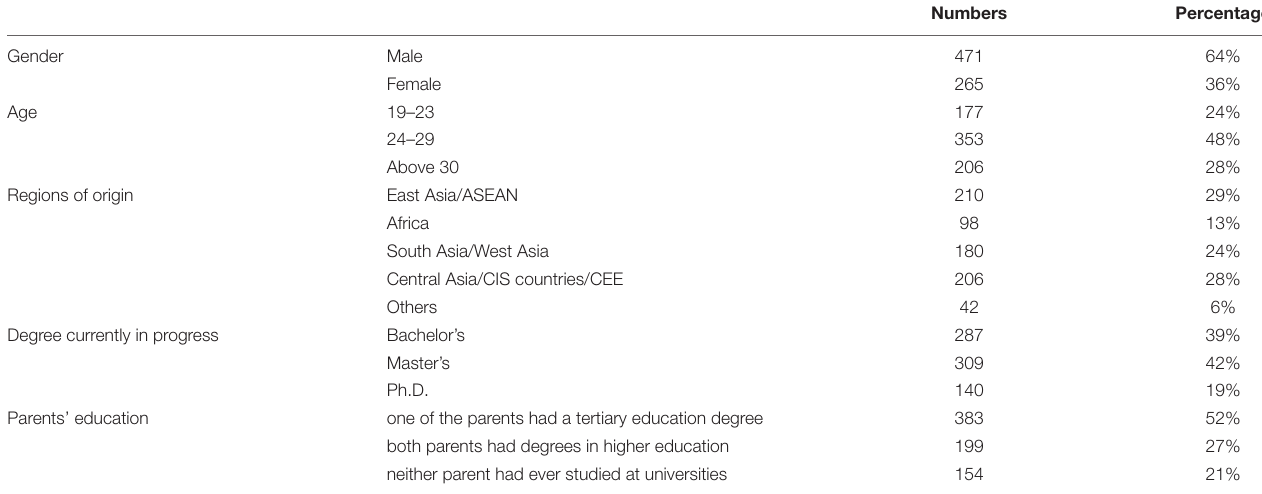
TABLE 1 | Sample demographics ( N = 736).